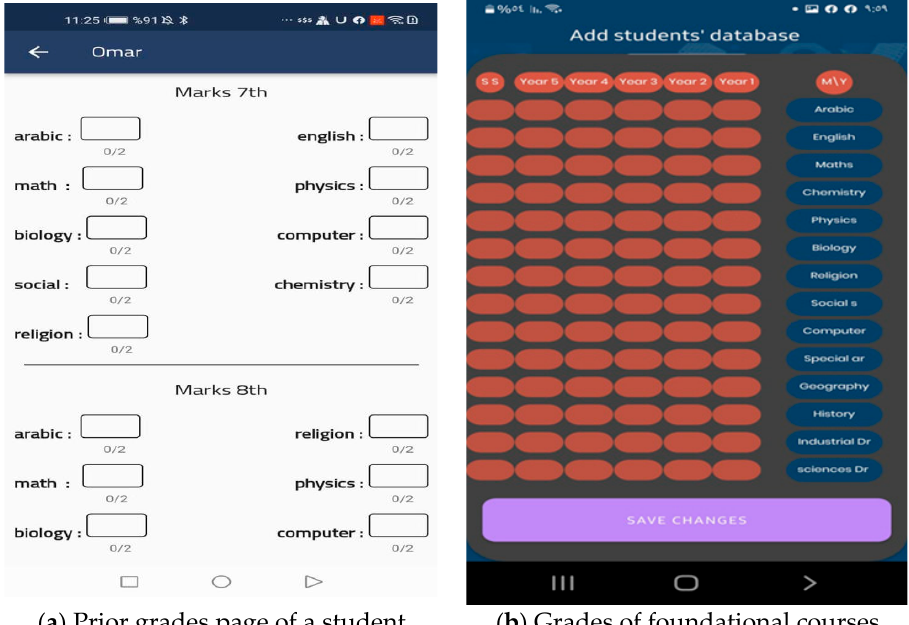
Figure 5. The grade screen from 7th to 11th grade.